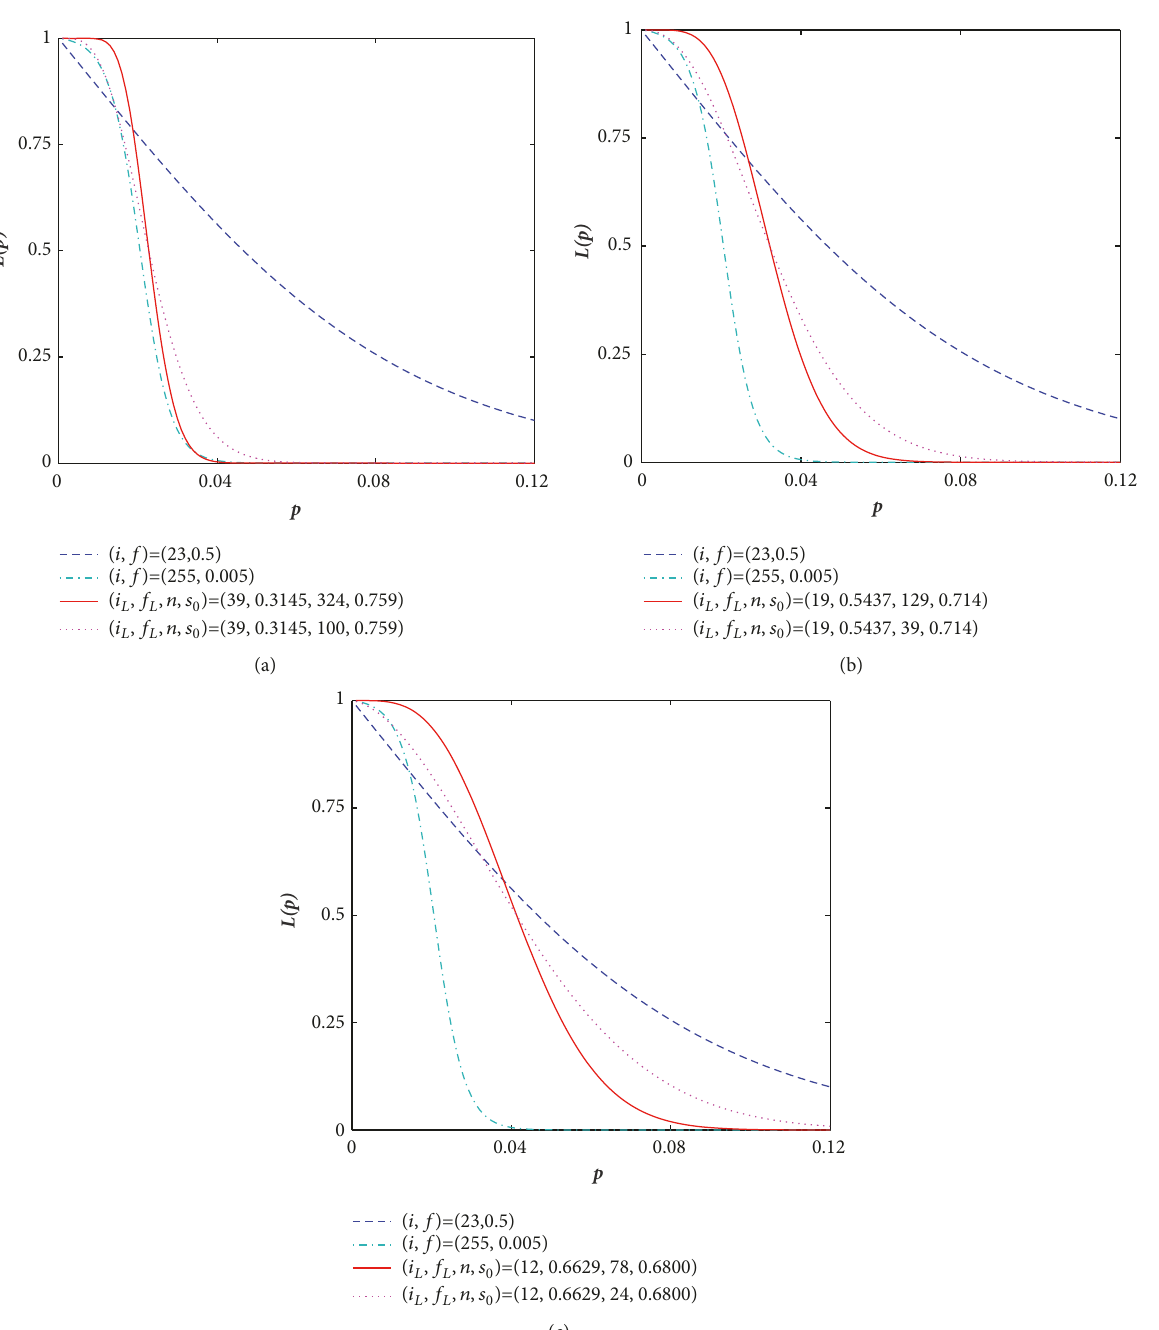
Figure 4: Comparisons of OC curves for the optimal schemes and inspection schemes in CSP-1 under AOQL = 0.0122 (a) at 𝐴𝐹𝐼 𝐿 = 0.6667 , (b) at 𝐴𝐹𝐼 𝐿 = 0.8 , and (c) at 𝐴𝐹𝐼 𝐿 = 0.8571